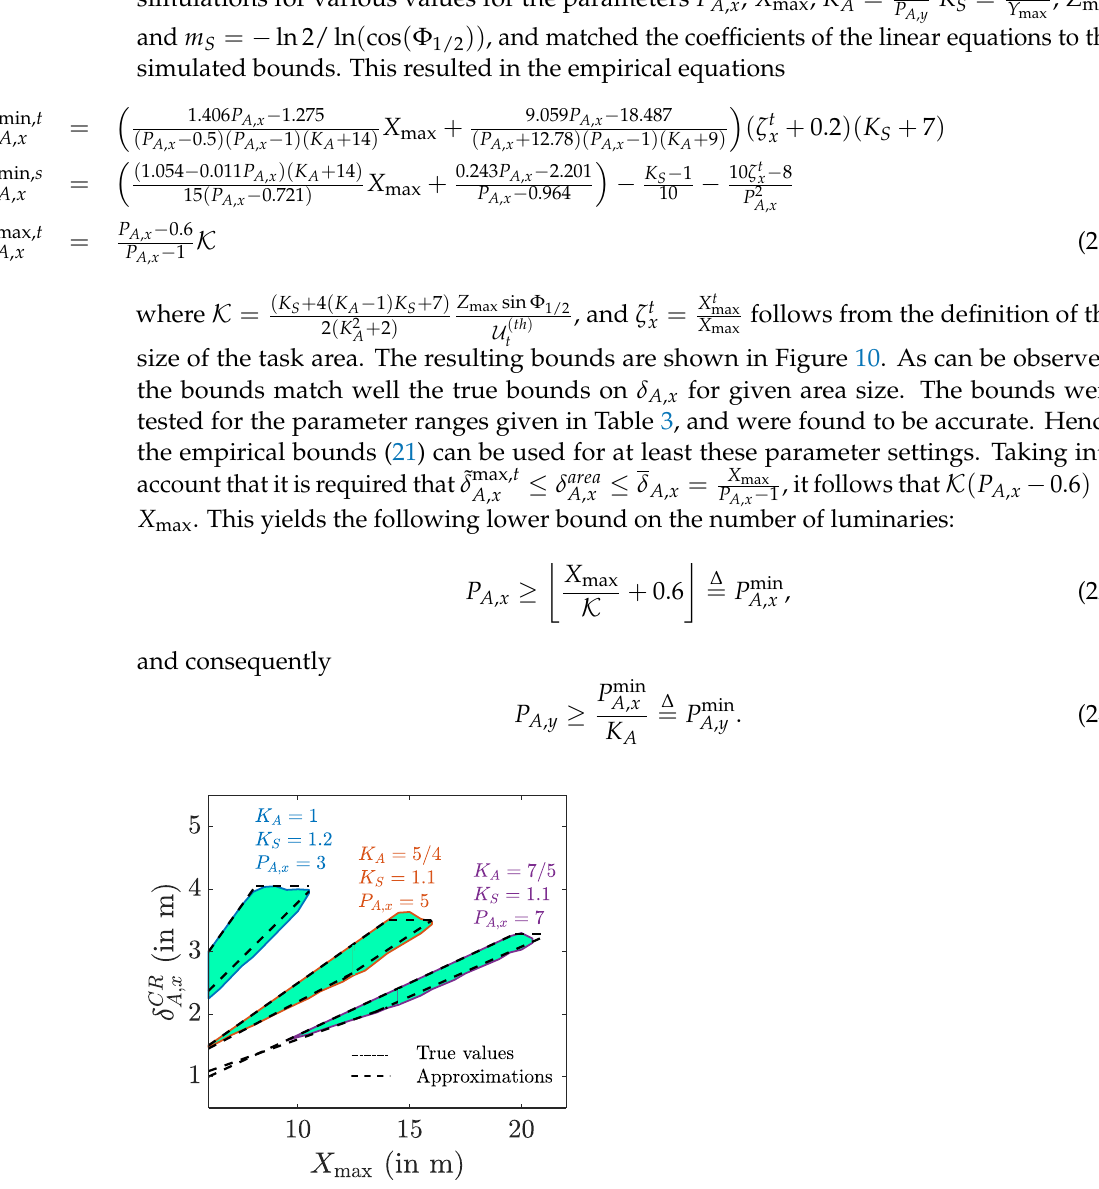
in the compliance region for different K A , K S and A , x